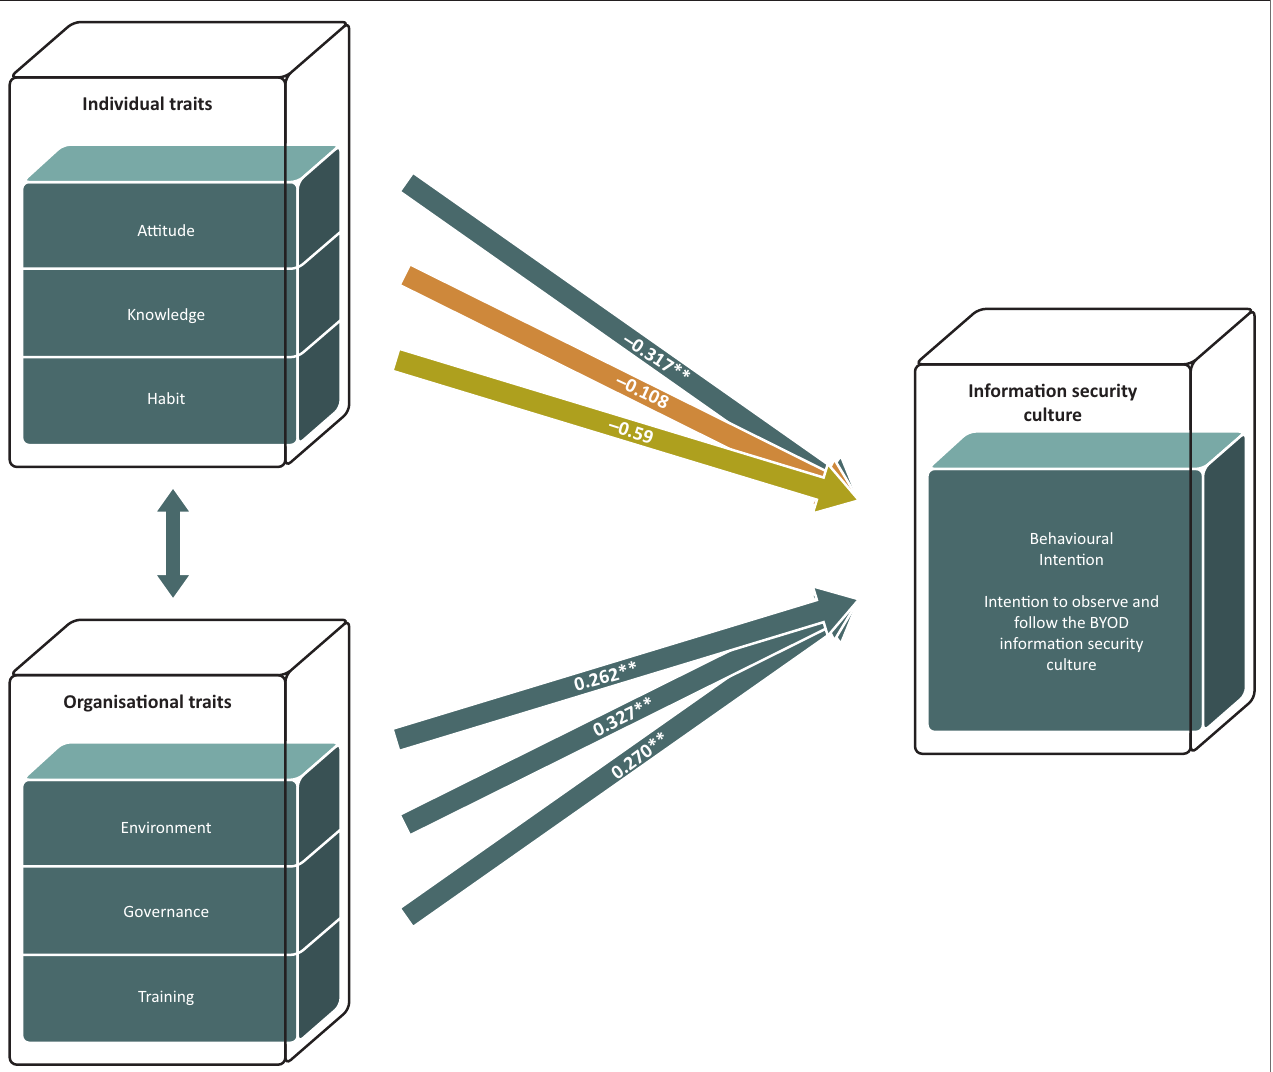
FIGURE 1: The ‘bring-your-own-device’ information security behavioural